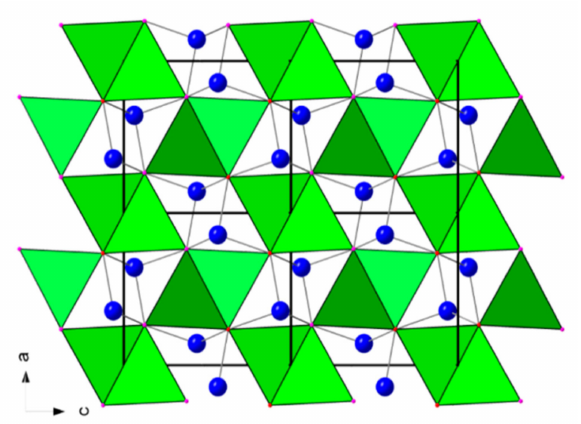
Figure 7. Polyhedral representation of the M 2P 5 distorted pyramids in the crystal structure of grammatikopoulosite. Colors and symbols as in Figure